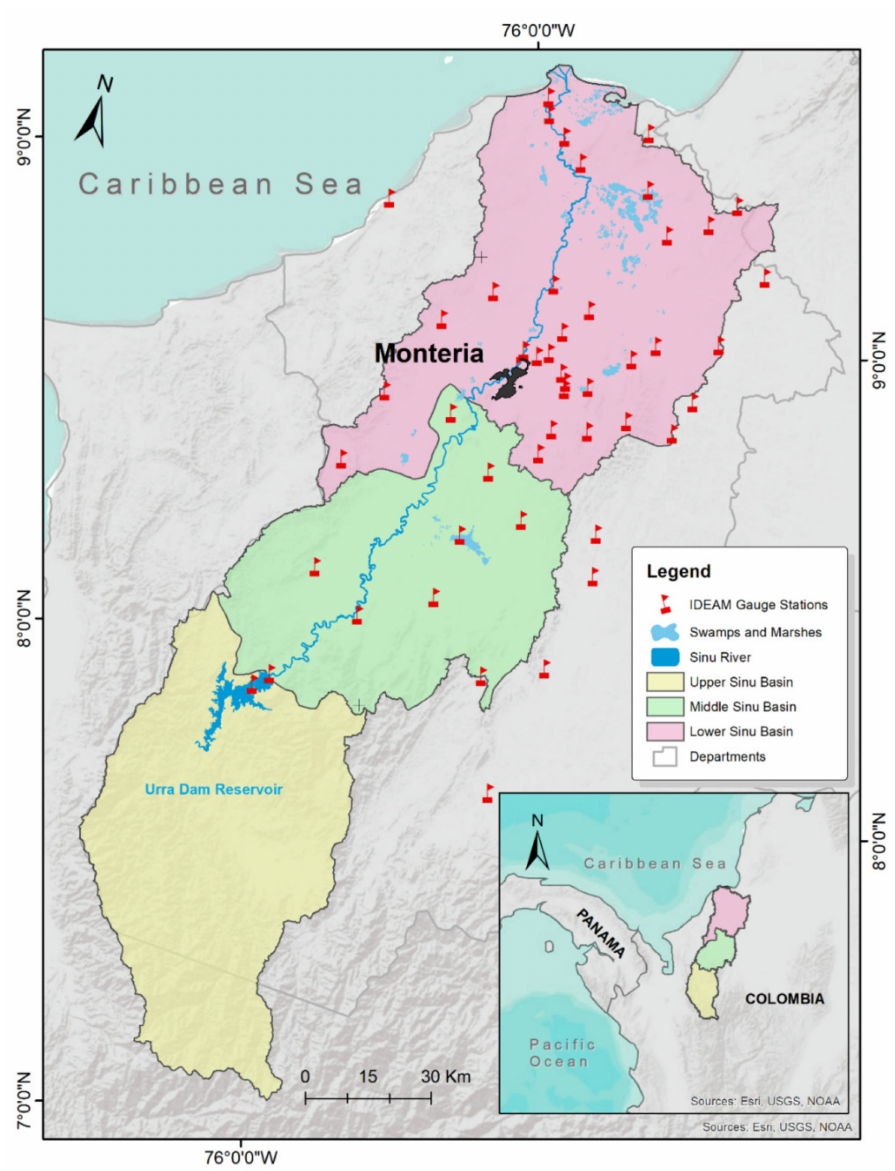
Figure 1. Location of the Sinu River basin and subbasins. The dark area in the lower subbasin corresponds to the metropolitan area of